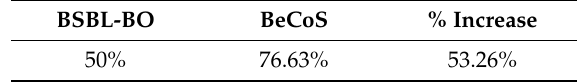
Table 2. Comparison of BSBL-BO and BeCoS compression ratios